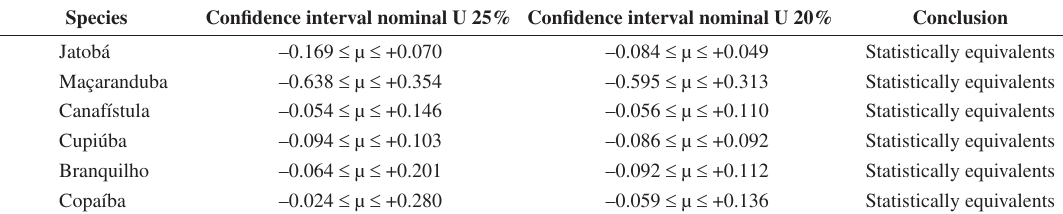
Table 6. Confidence intervals of average differences: E12/Eu (Exp) e E12/Eu (5).